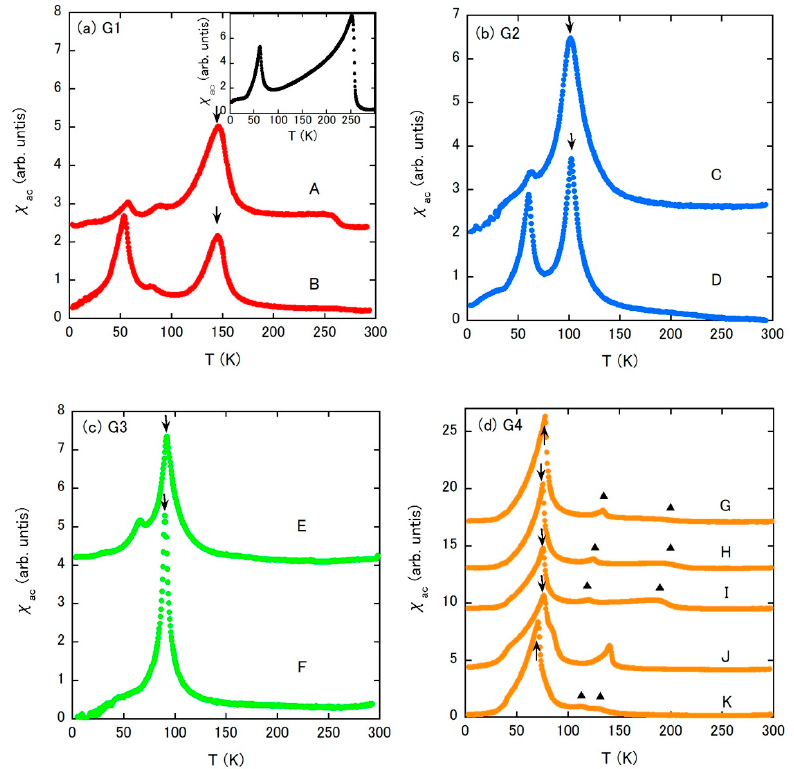
Figure 6. Temperature dependences of χ ac for samples ( a ) A and B, ( b ) C and D, ( c ) E and F, and ( d ) G to K, respectively. The origin of each χ ac is shifted by a value for clarity. The inset of ( a ) is the χ ac (T) of the sample, with the starting composition of Tb 42.9 Co 50 Ga 7.1 .